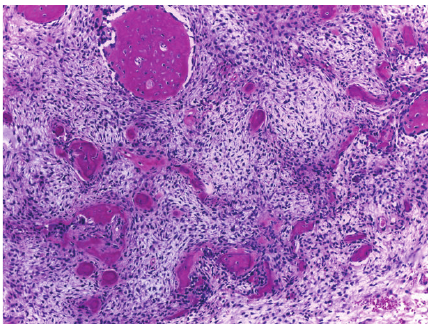
Figure 4: Removal of the lesion by enucleation with curettage.